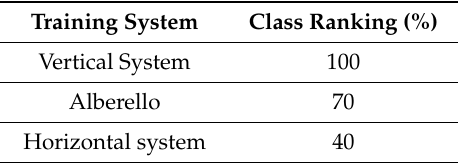
Table 4. Categorisation by mechanical accessibility of the training systems in Italian